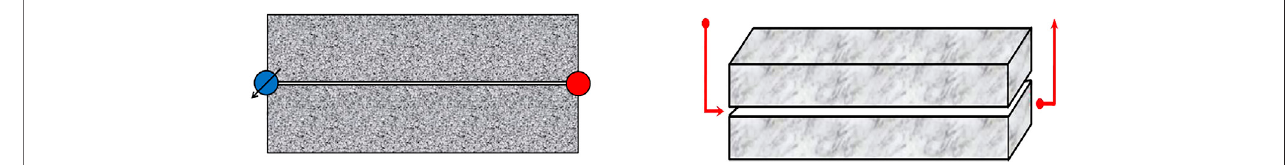
FIGURE 1 | Physical model of single fracture in one injection-production